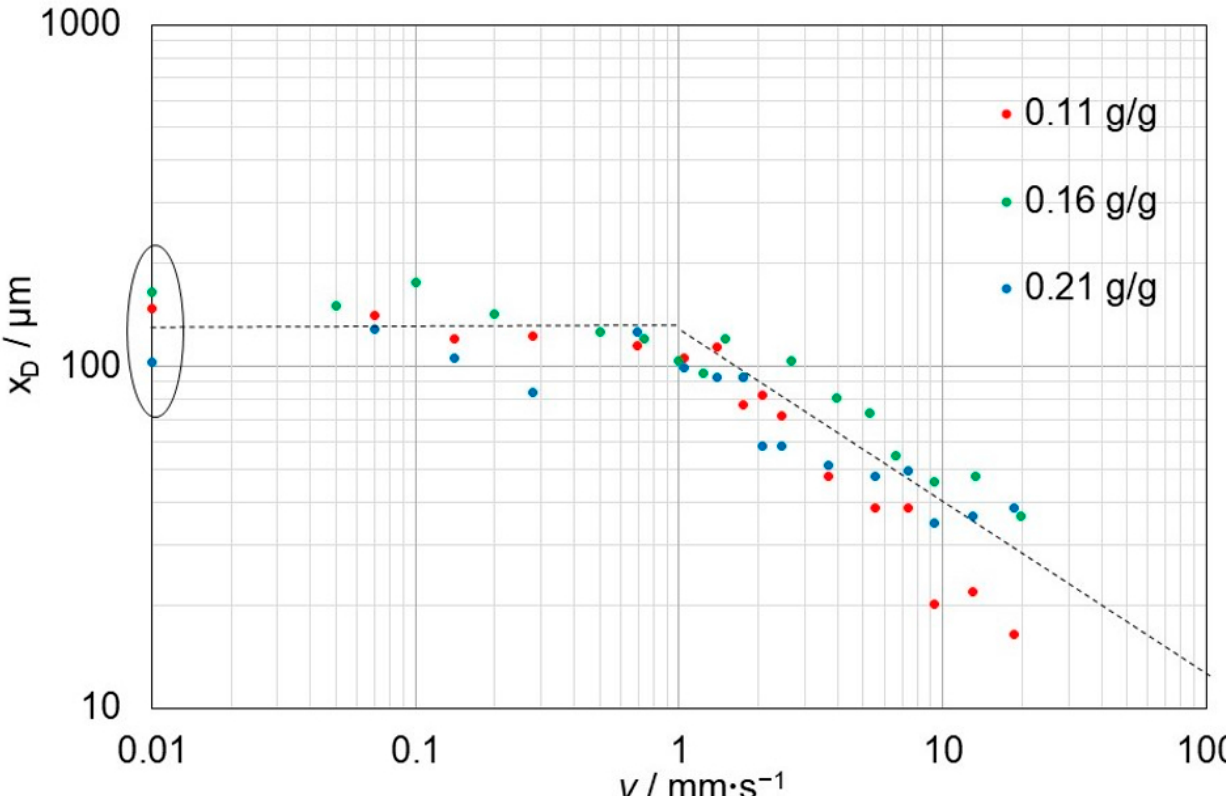
Figure 11. Thickness of the diffusive layer at the (110) glycine facet in moving glycine solutions. Values at stagnant flow (oval marking) are entered at v = 0.01 mm/s to show them in the logarithmic representation.